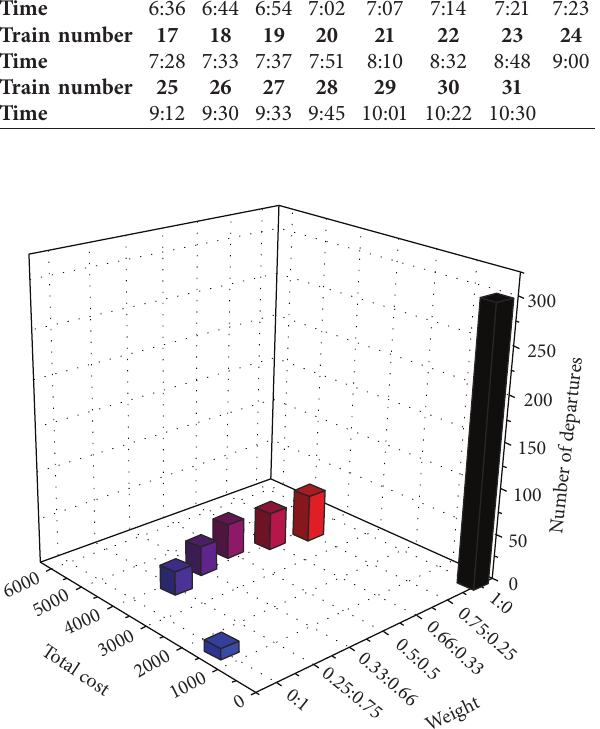
Figure 7: Total cost and the number of departures under different